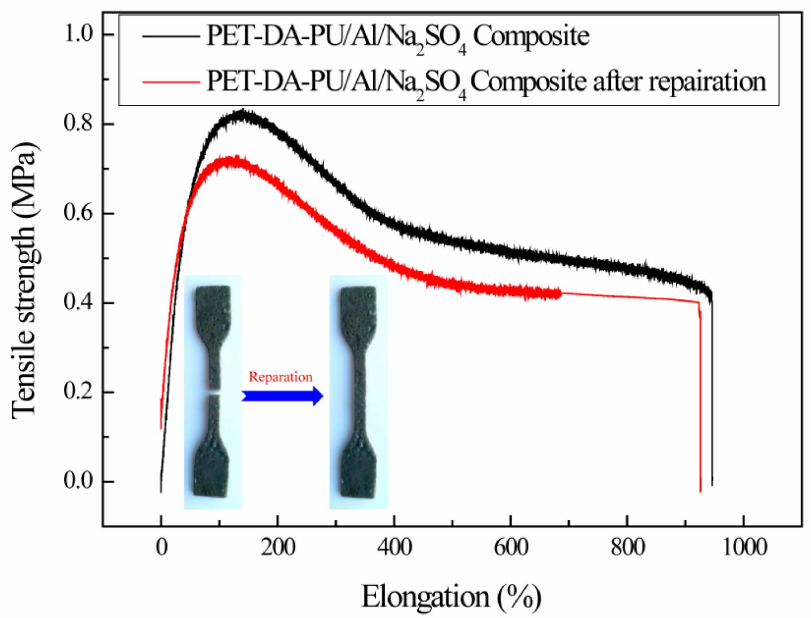
Figure 9. Mechanical property of PET-DA-PU/Al/Na 2 SO 4 composite and its damaged and healed samples. Table 1. Tensile testing of PET-DA-PU/Al/Na 2 SO 4 composites before and after